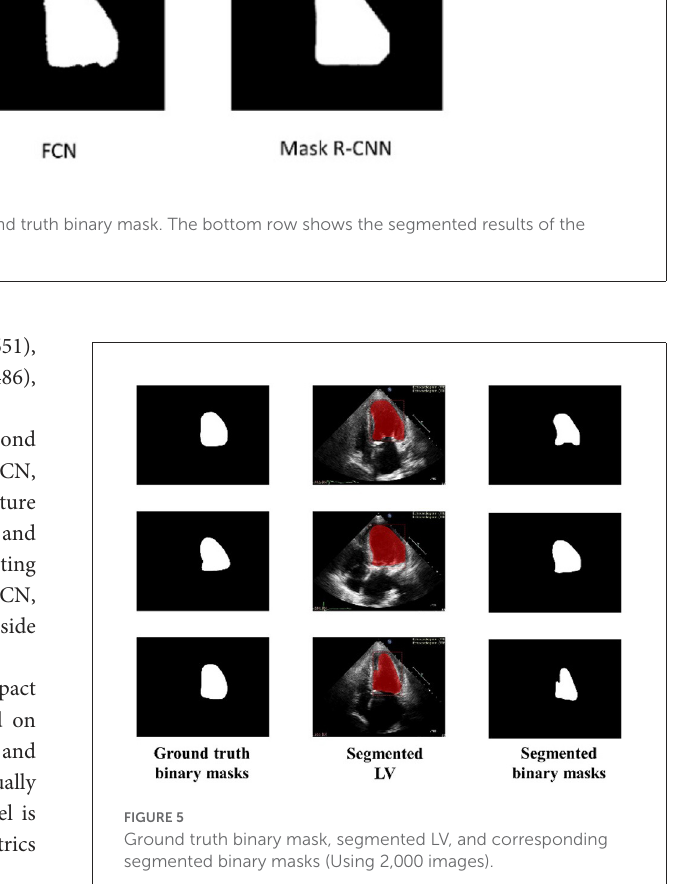
FIGURE5 Ground truth binary mask, segmented LV, and corresponding segmented binary masks (Using 2,000 images).